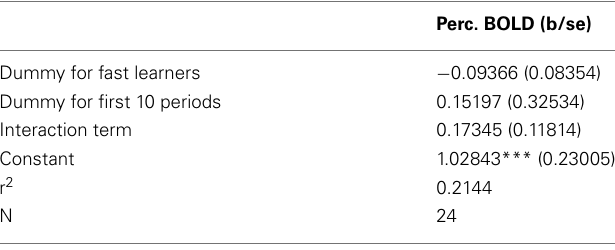
Table 4 | Interaction between fast/slow learner, and early/late trial on BOLD signal contrast position 11 – position {1, 2} in